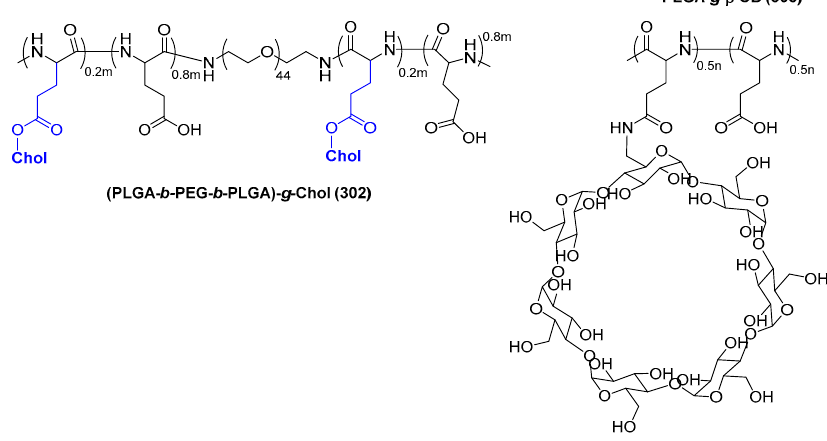
Figure 5. Chemical structures of ( PLGA- b -PEG- b -PLGA)-g-Chol and PLGA- g - β -CD .